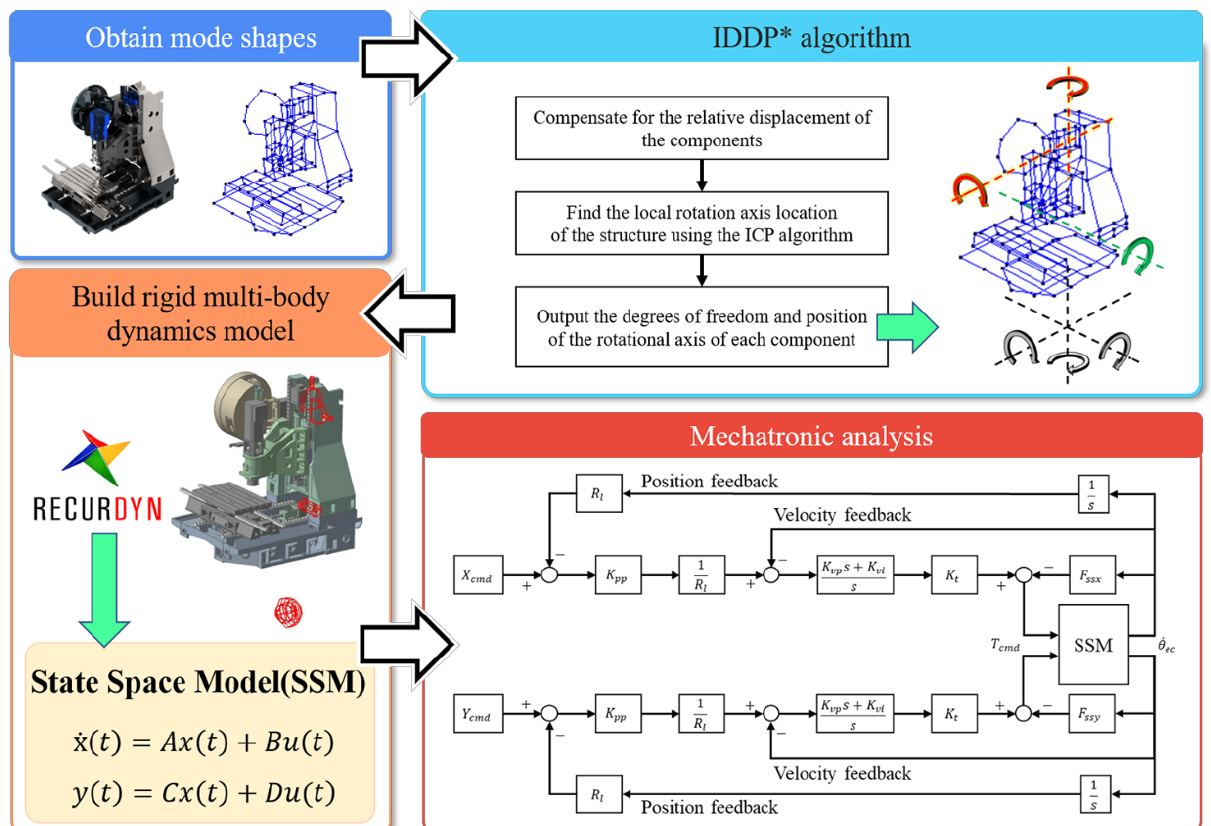
Figure 1. Overall research process.